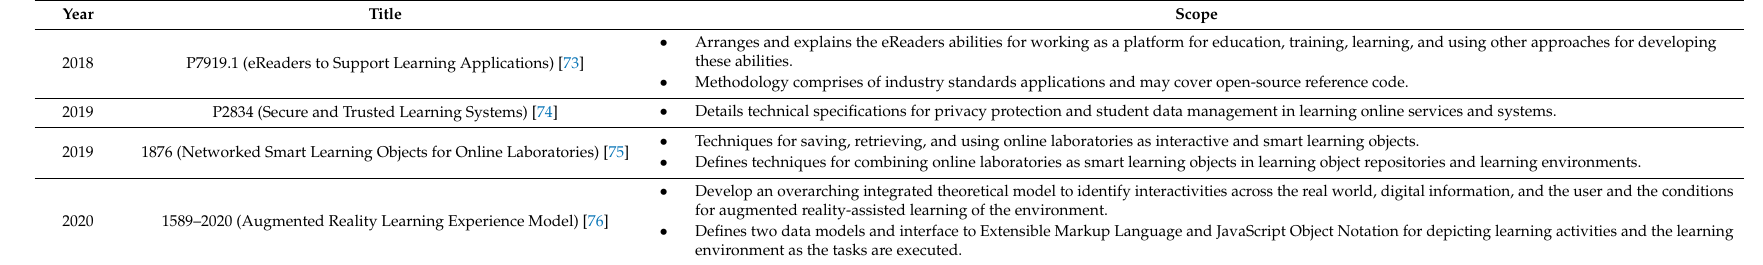
Table 4. Recent IEEE Standards in development for smart education.